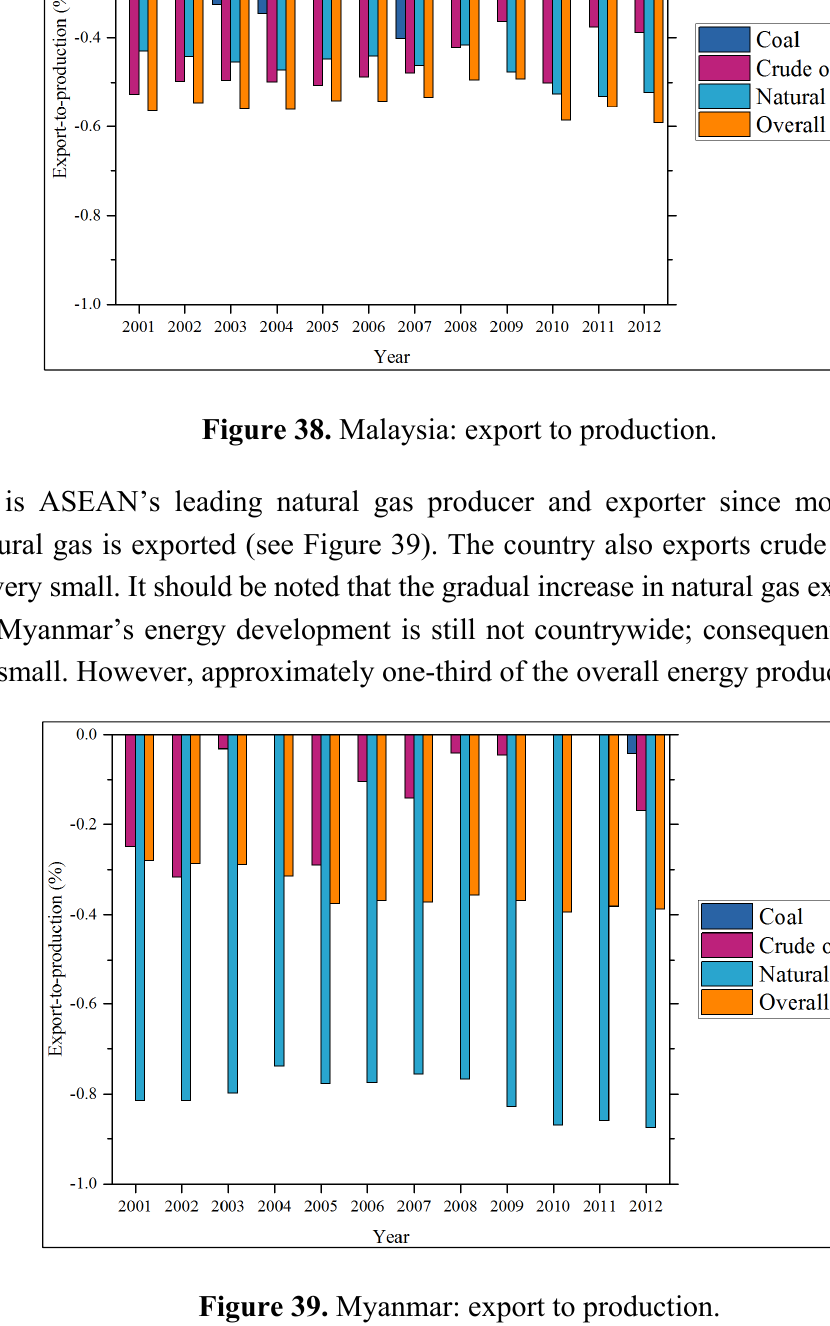
Figure 39. Myanmar: export to